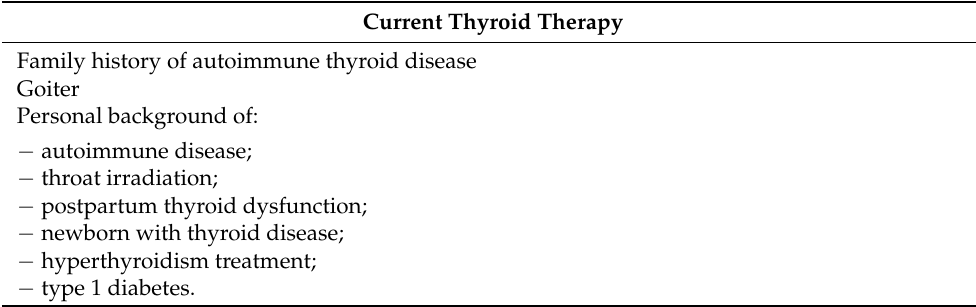
Table 2. Endocrinology Society recommendations for thyroid screening in pregnancy